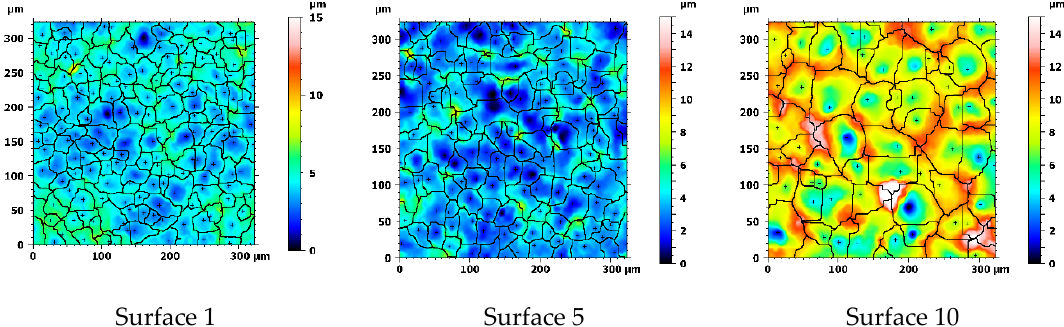
Figure 6. Visualization of effects of the watershed segmentation. Surfaces with watershed boundaries (ridge lines) superimposed on a surface image.